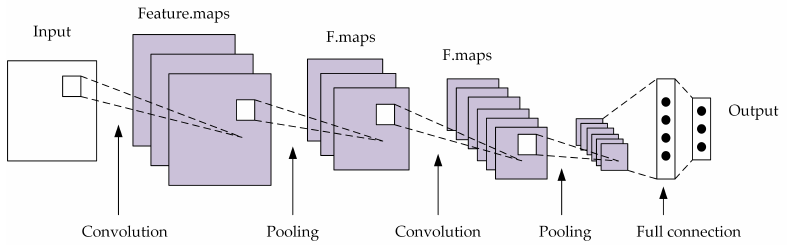
Figure 1. The structure of typical convolutional neural